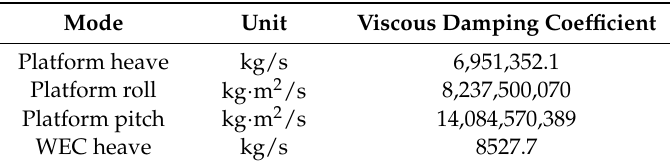
Table 4. Platform and WEC viscous damping coefficients.